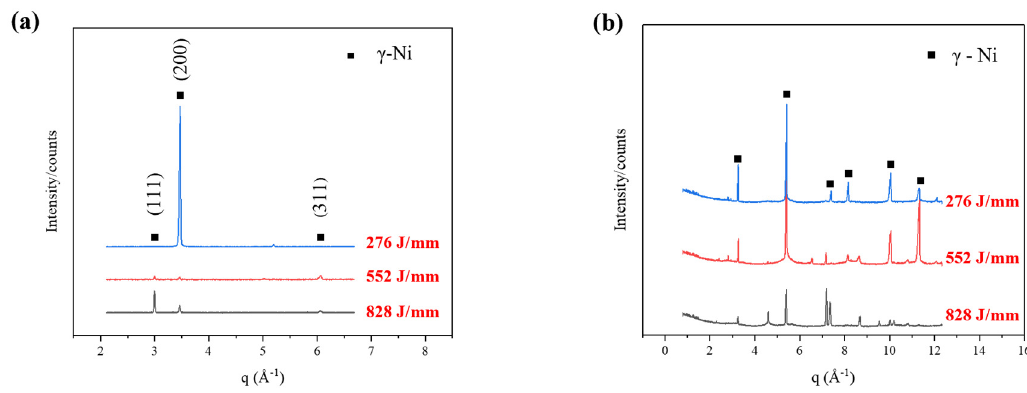
Figure 7. Solidification rate of the as-deposited samples with different heat inputs.